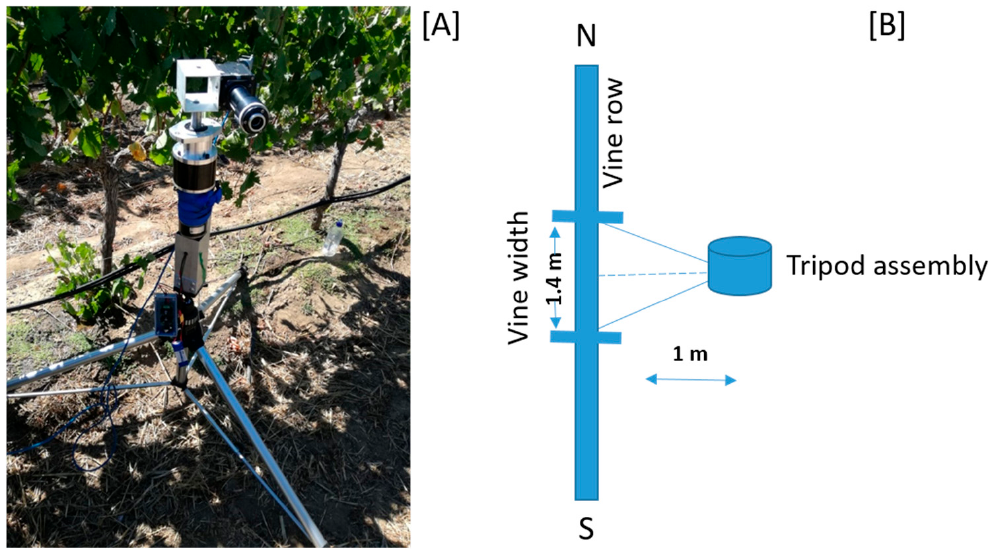
Figure 3. The hyperspectral sensor tripod assembly ( A ); and in-field setup when collecting terrestrial imagery of the vine canopy ( B ).